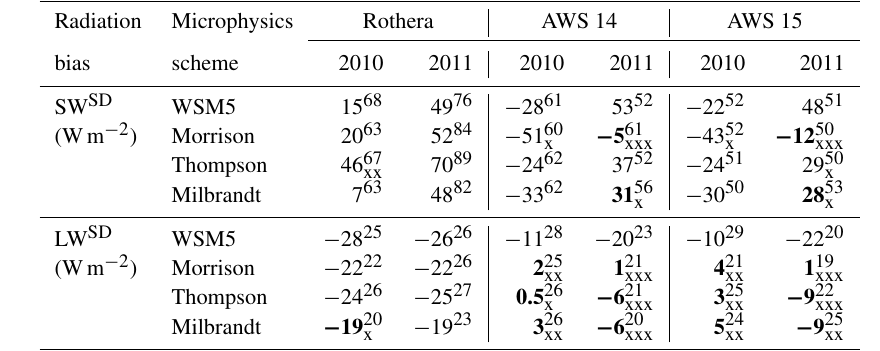
Table 4. Monthly averaged shortwave (SW) and longwave (LW) surface radiative biases of daily averaged biases over Rothera, AWS14, and AWS15 for the two time periods of interest. The exponent gives the standard deviation (SD) of the daily biases. The number of “x” symbols as subscript tells how significant the difference is between WSM5 and each of the other three schemes (one, two, or three “x”s means statistical significance at the 90, 95, or 99% level, respectively). No symbol means that the difference is not significant. Statistically significant reductions in SW/LW biases are emphasized with bold